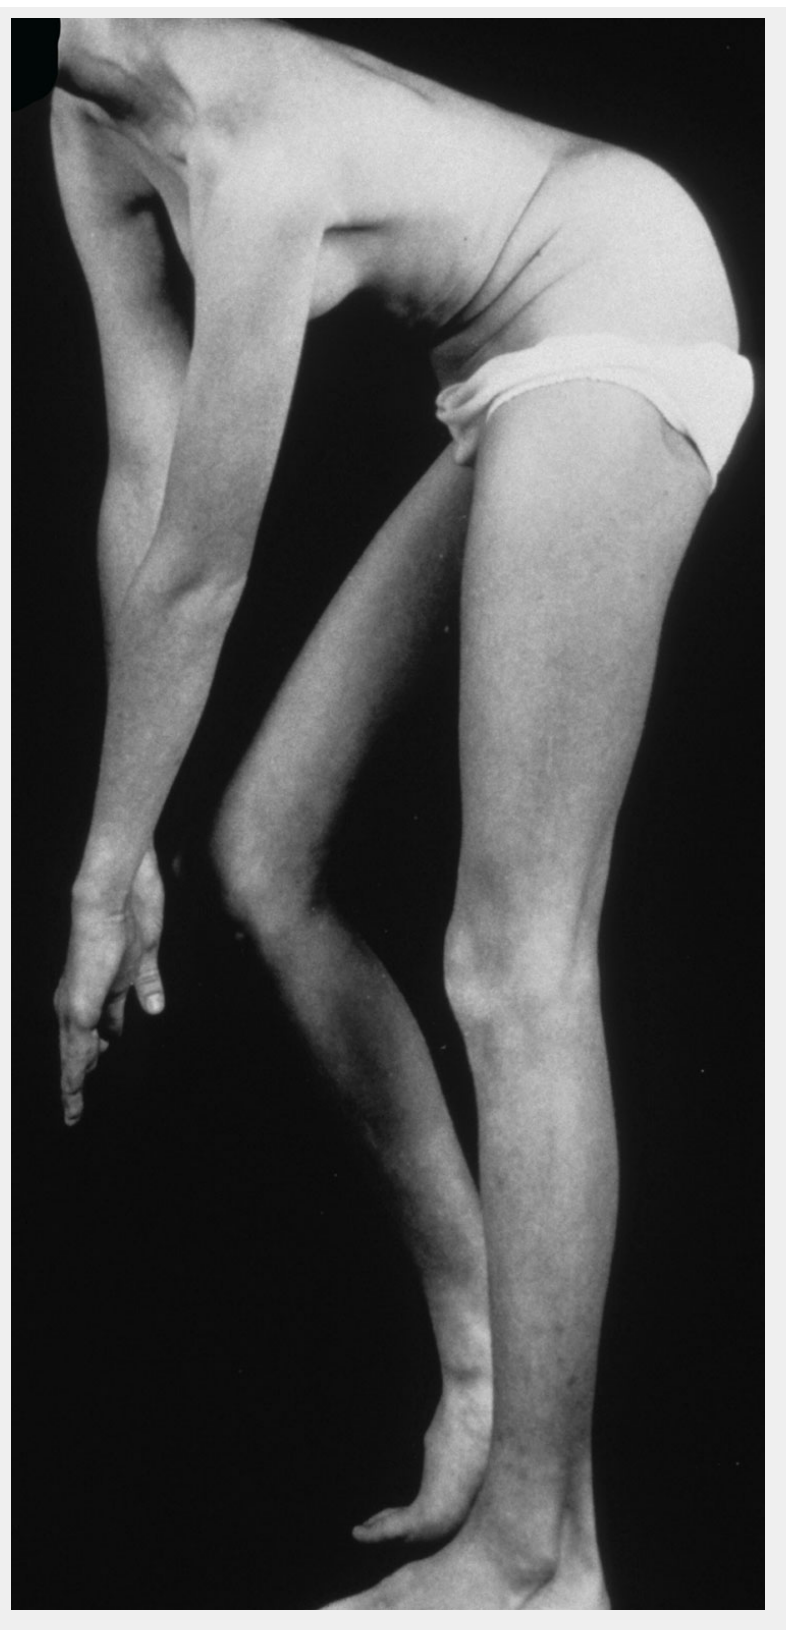
Figure 3 A 15-year-old female presenting with posterior thigh pain and an increasing stiffness. She shows a vertical sacrum, flattening of the thoracic and lumbar spine and an inability to round her back and to bend